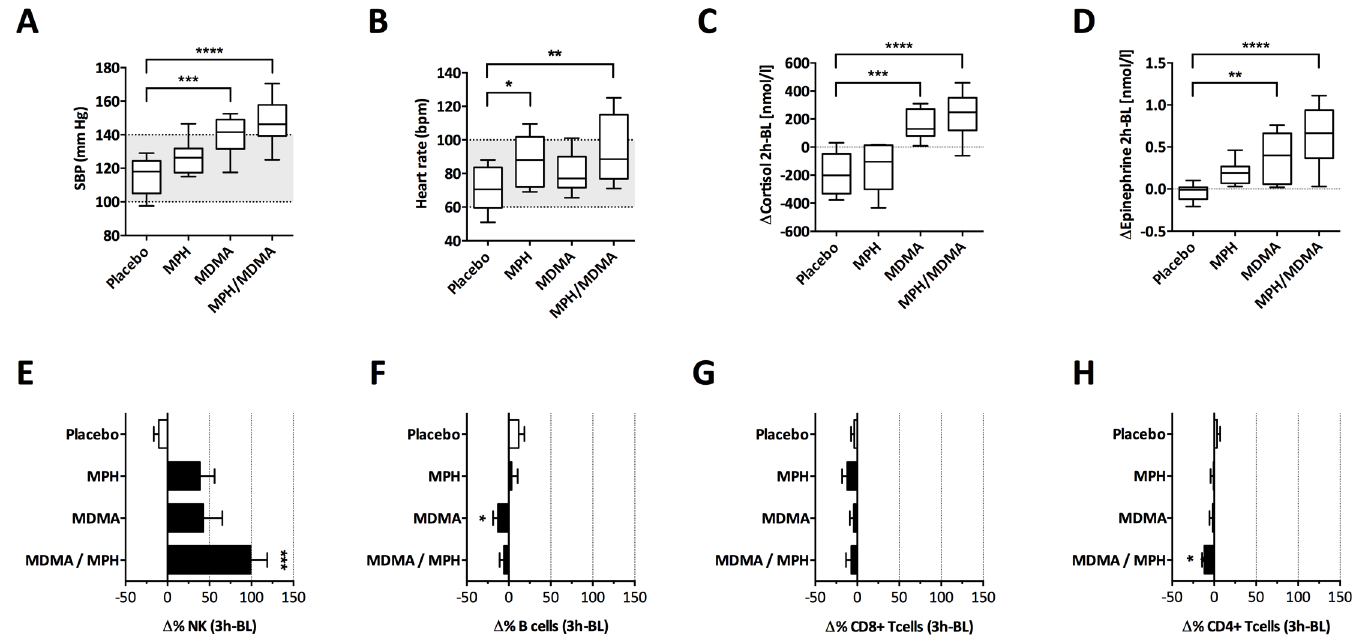
Fig 1. Drug-induced stress induces a pronounced cardiovascular responses and NK cell recruitment. (A) Systolic blood pressure (SBP) in mmHg and (B) heart rate (HR) in beats per minute (bpm) are shown three hours (i.e. one hour after the stress hormone peak) post-adminstration of the study drug (n = 12). The grey shaded area indicates the normal values. Serum cortisol (C) and epinephrine (D) levels were measured before and two hours post drug administration and the difference from baseline was calculated. Box plots indicate median and IQR, whiskers indicate range. (E-H) Lymphocyte subset distribution 3 hours after drug administration was examined (n = 12). Percent change from baseline level to three hours post administration ( Δ %) was calculated for each lymphocyte subset. Mean Δ % and S.E.M is shown for the four main lymphocyte subsets: (E) NK cells (CD3 - CD56 + ), (F) B cells (CD3 - CD19 + ), (G) CD8 cytotoxic T cells (CD3 + CD8 + ) and (H) CD4 T helper cells (CD3 + CD4 + ). Kruskal-Wallis test with Dunn ’ s correction to test for multiple comparisons was used ( * p < 0.05, ** p < 0.01, *** p < 0.001, **** p < 0.0001).